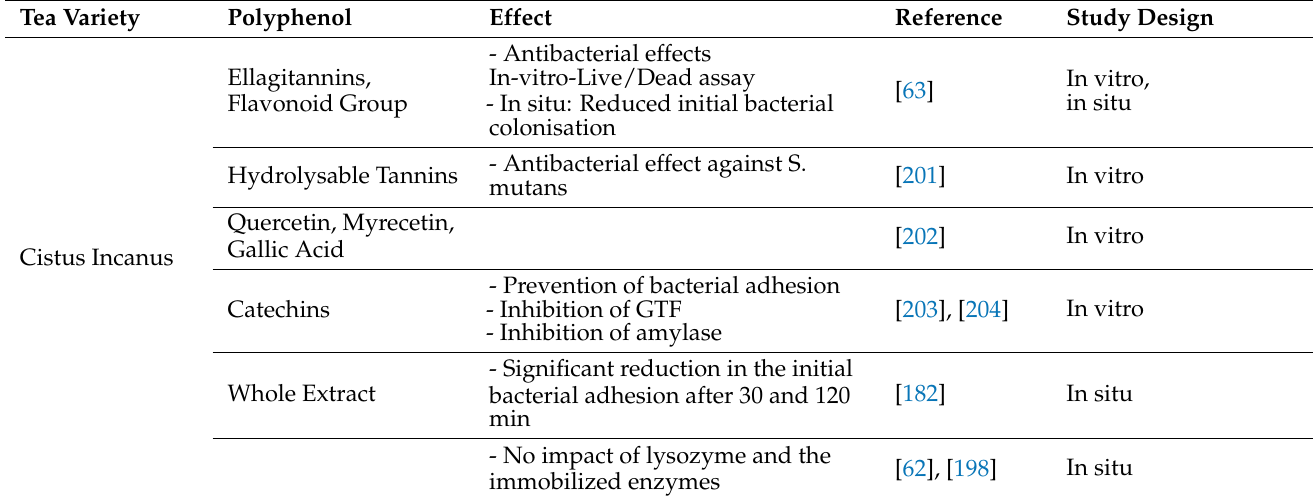
Table 3. Comparison of different tea polyphenols and their effect on the tooth surface. Tea Variety